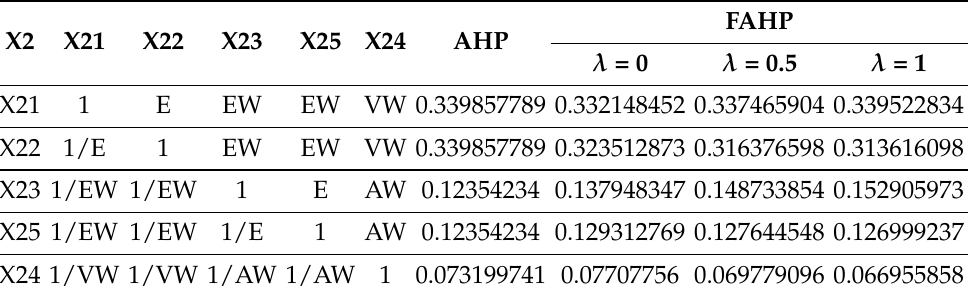
Table 5. Fuzzy comparison matrix for the sub-criteria X2. ( CI = 0.006617, CR = 0.005908).